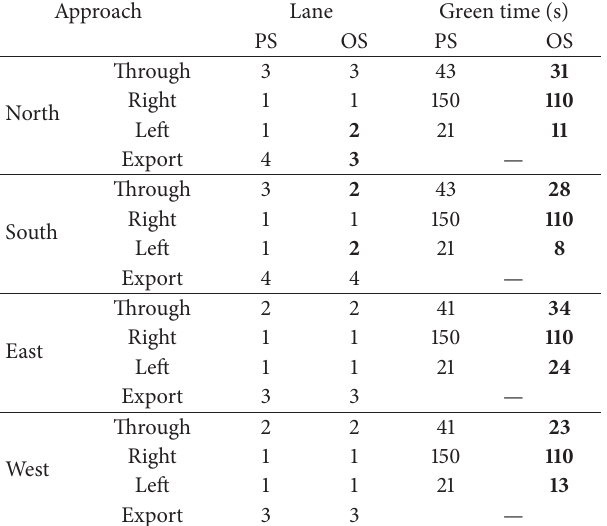
Table 3: Optimization for morning peak.